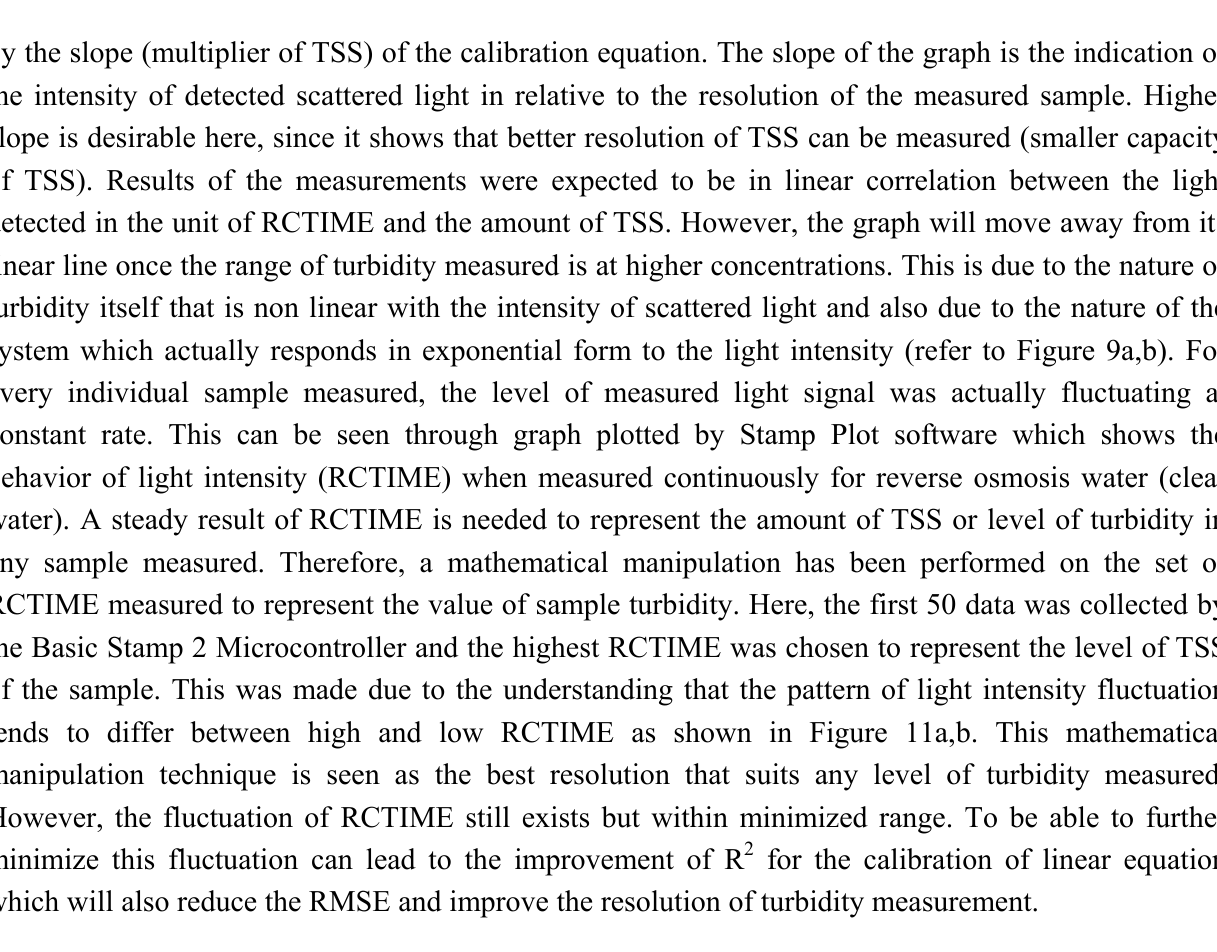
Figure 11. Stamp Plot Graph for Reverse Osmosis Water Collected by BLUE System through (a) Backscattered Measurement (b) Transmittance